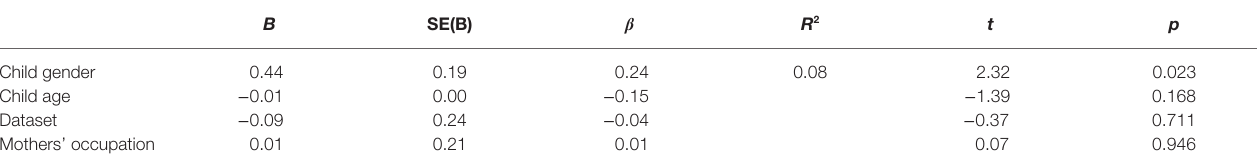
TABLE 5 | Linear regression for the effects of mothers’ occupation on elementary school children’s communal occupational aspirations while controlling for child gender and